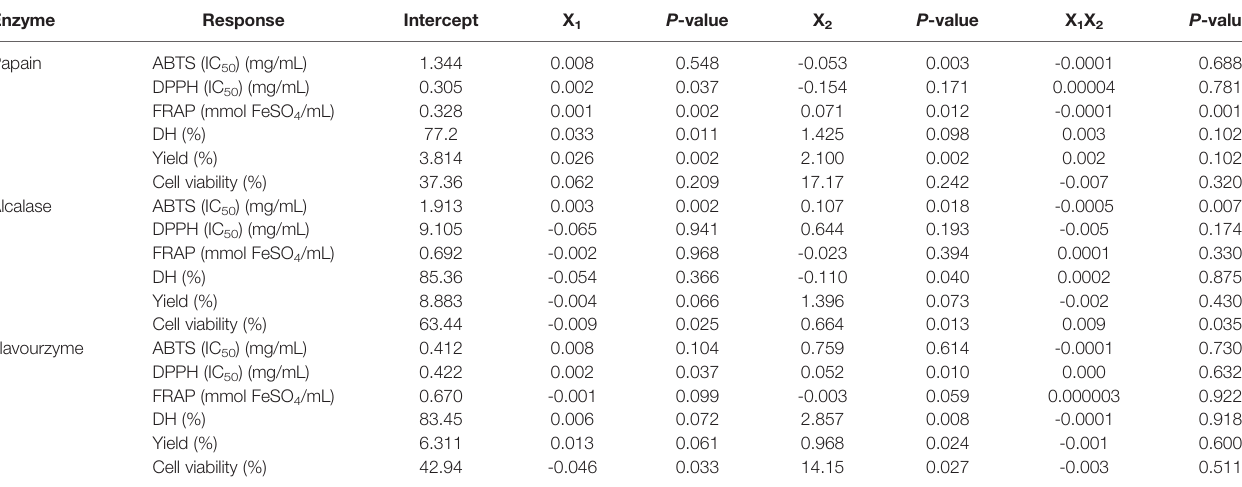
TABLE 4 | The constants, coef fi cients and P -values of independent variables and interactions for all responses of sea cucumber hydrolysis with different three enzyme. Enzyme Response